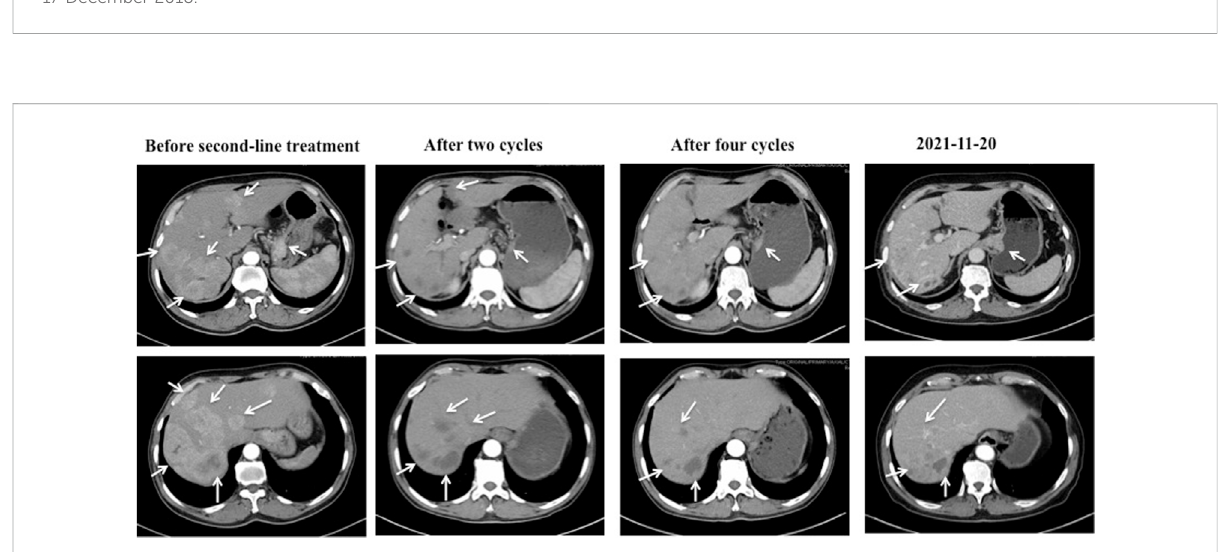
FIGURE 1 The CTimagesofthe cardiac cancer and hepatic metastases before and after fi rst-line chemotherapy. The cardiactumor withmultiplehepatic metastases were indicated on 15 August 2017. After two cycles of fi rst-line chemotherapy with oxaliplatin and S-1, the cardiac and hepatic lesions showed stable disease (SD) on 8 November 2017. Five months after fi rst-line treatment, the cardiac and liver masses were progressed on 17 December 2018.